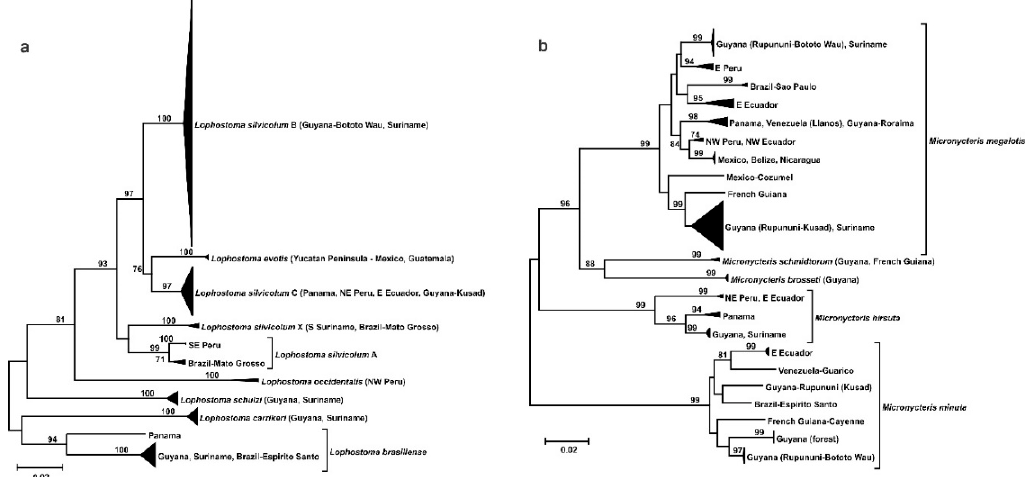
Figure 6. DNA barcoding trees of bat species with complex phylogeographic structuring involving the Guianan savannas: ( a ) Lophostoma and ( b ) Micronycteris .